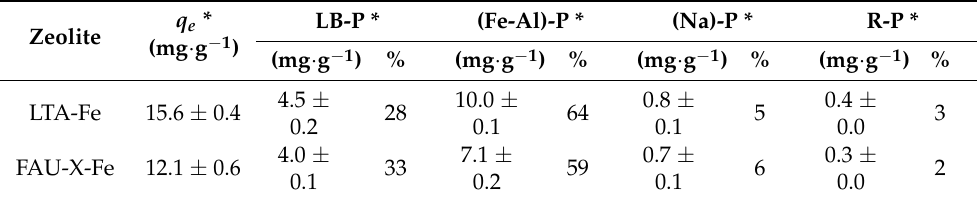
Table 7. Fractions of phosphate bonded to LTA-Fe and FAU-X-Fe.